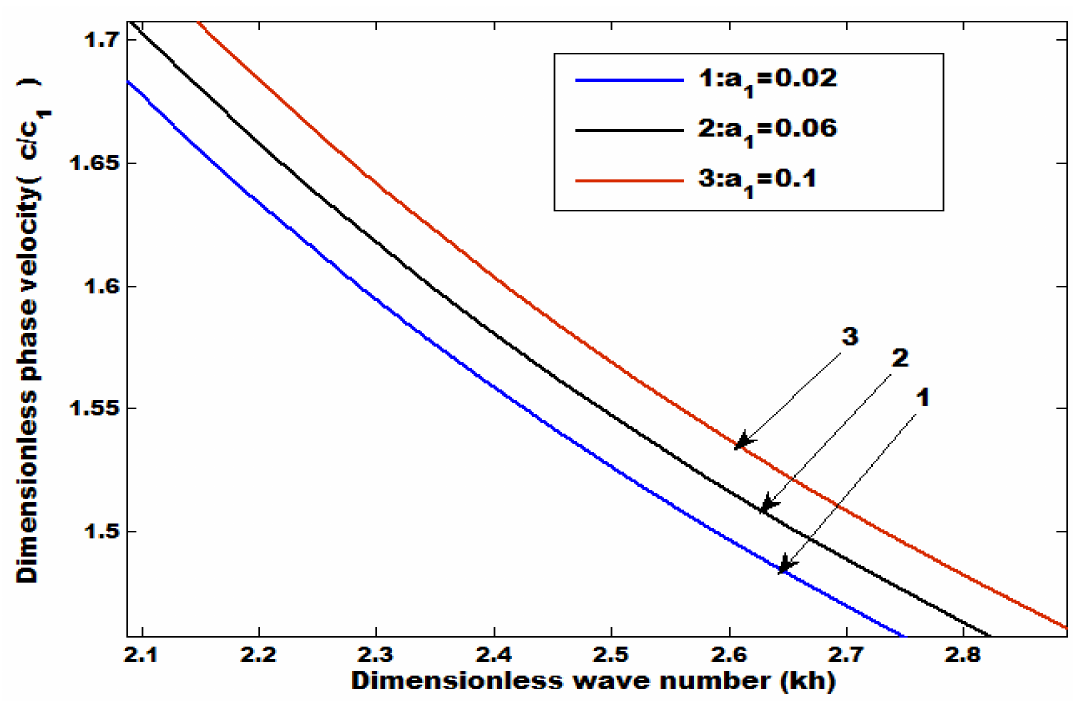
Figure 9. The phase velocity with wave number when m = 0.08, a 2 = 0, h = 0.04, p = 0.01, α = 0.2, β = 0.1. Figures 10–12 are made to observe the effect of various parameters on group velocity. Figure 10 indicates the influence of coupling parameter on group velocity. As the coupling parameter increases, the group velocity also increases. Figures 11 and 12 describe the impact of heterogeneous parameters on group velocity. The group velocity declines as heterogeneous parameters increase.